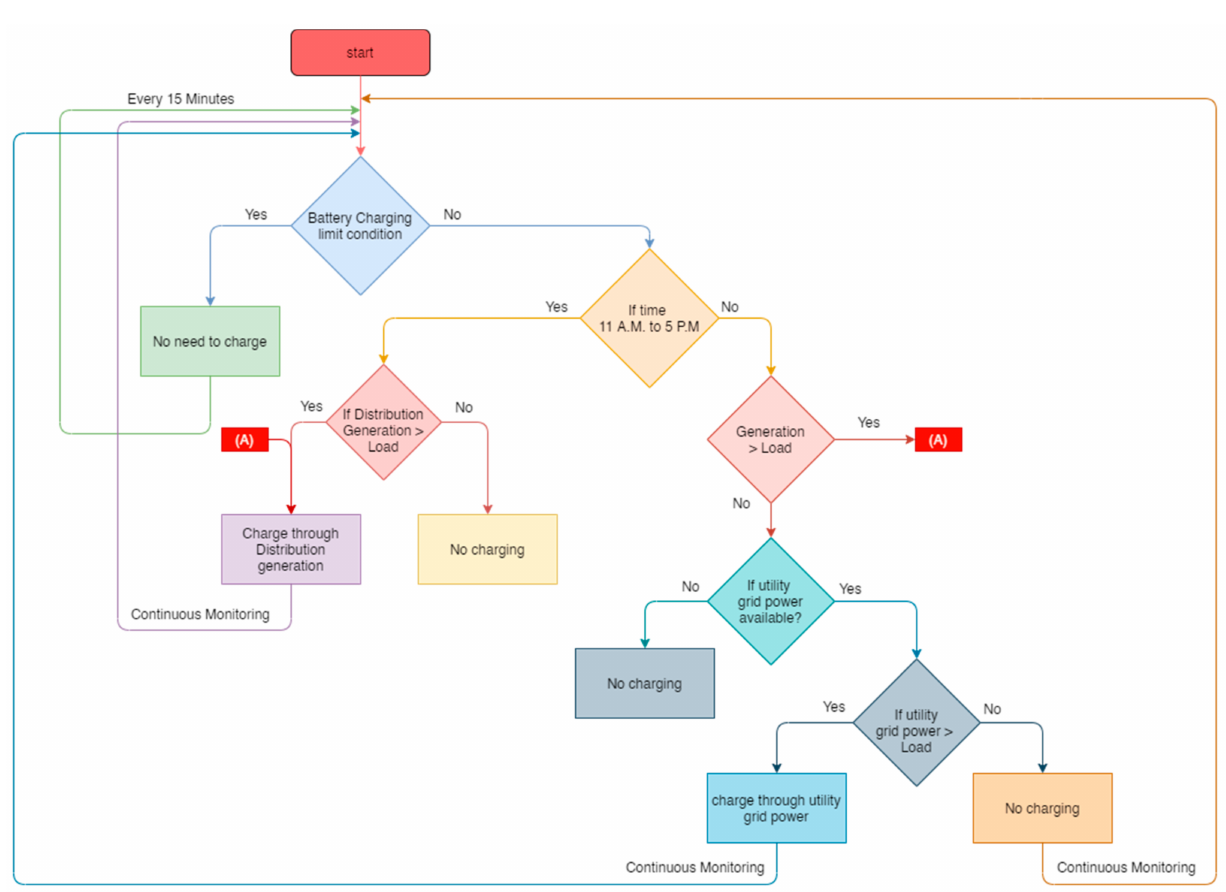
Figure 2. Battery Charging